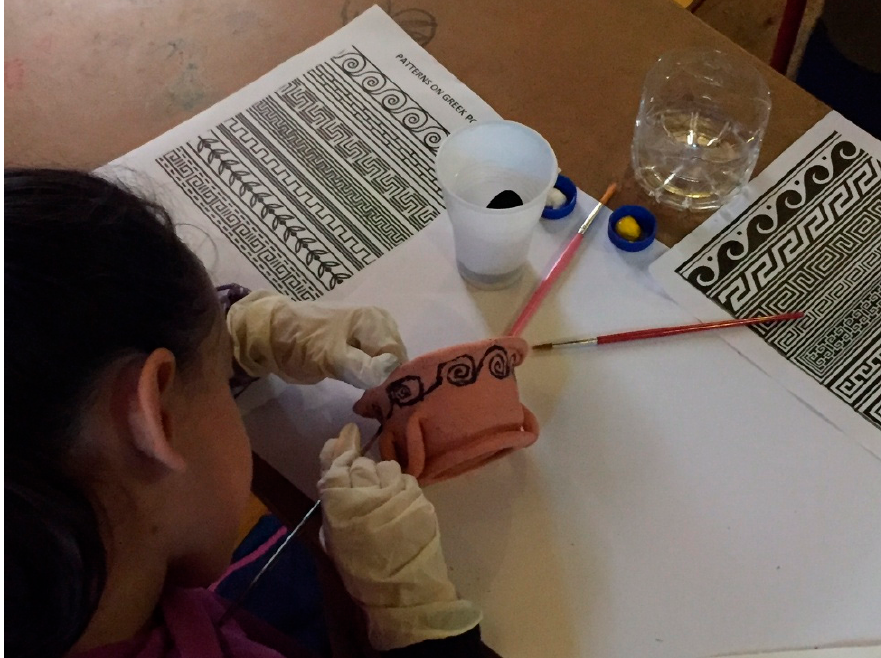
Figure 2. Greek vase-painting. Photo by author.